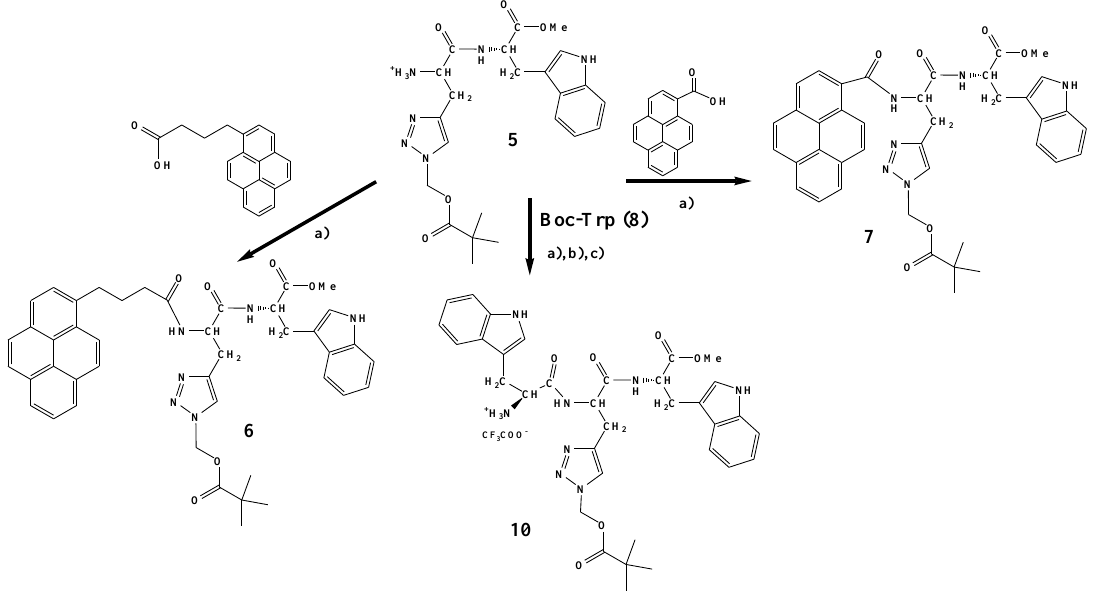
Scheme 2. Synthesis of W-A(triazole)-Pyr conjugates 6 and 7 and W-A(triazole)-W tripeptide